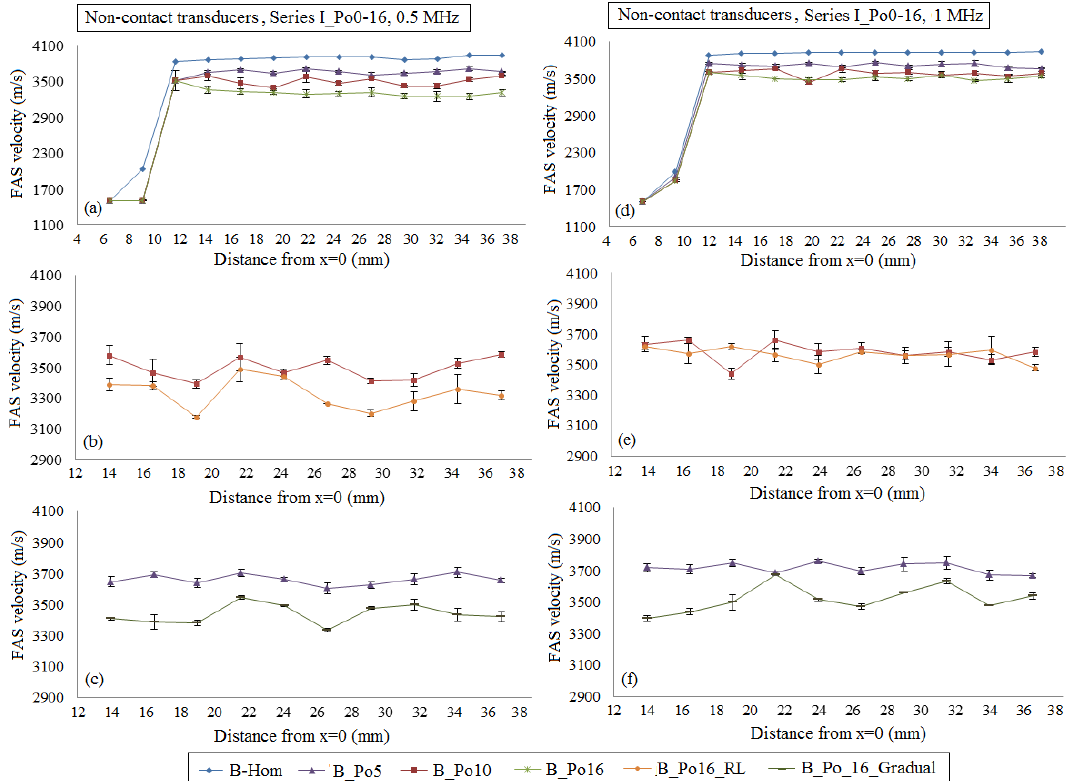
Figure 8. The potential of the mean local FAS velocity to detect changes in cortical porosity from 0% to 16%. The diagrams correspond to the first set of simulations when the transducers are placed at a distance of 2 mm from the cortical cortex. The results for the excitation frequencies : ( a )–( c ) 0.5 MHz; and ( d )–( f ) 1 MHz are presented. The standard error bars demonstrate the FAS velocity variation for the three numerical models established for each porosity scenario.